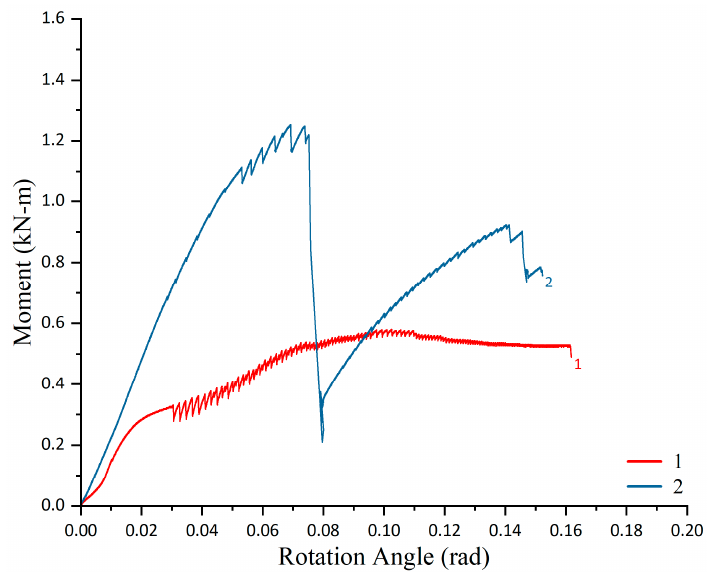
Figure 13. Original specimens and joints retrofitted by moment-constraining STS.